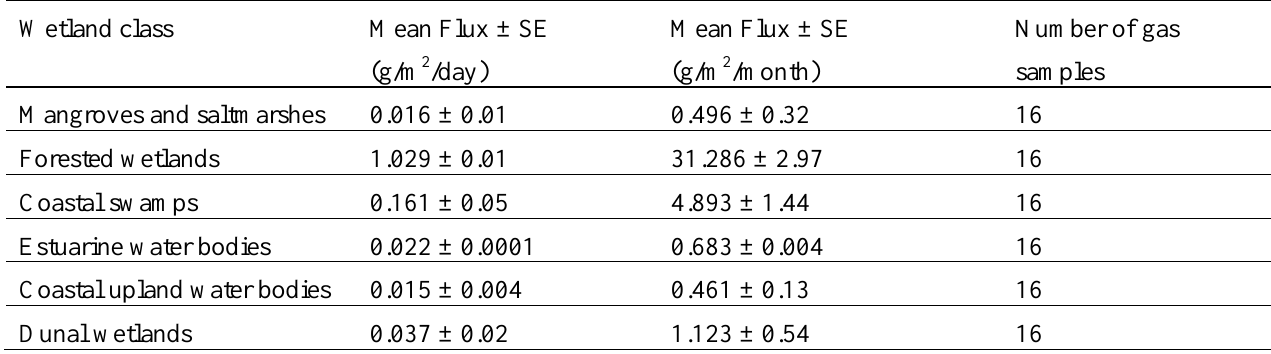
Table 5. Estimated mean methane fluxes for the wetland classes.